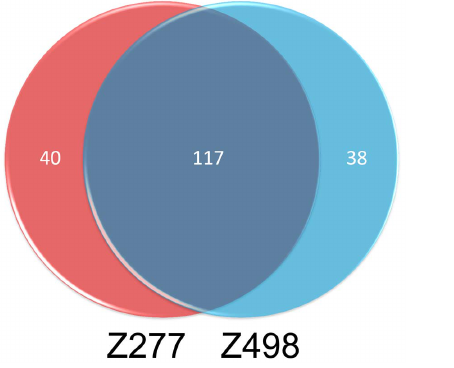
Figure 5. This graph shows the overlapped PROFEAT features of Z277 and Z498. After feature selection by SVM-REF, 157 and 155 PROFEAT features are selected in top322 features for datasets Z277 and Z498, and have significant overlap (117 common